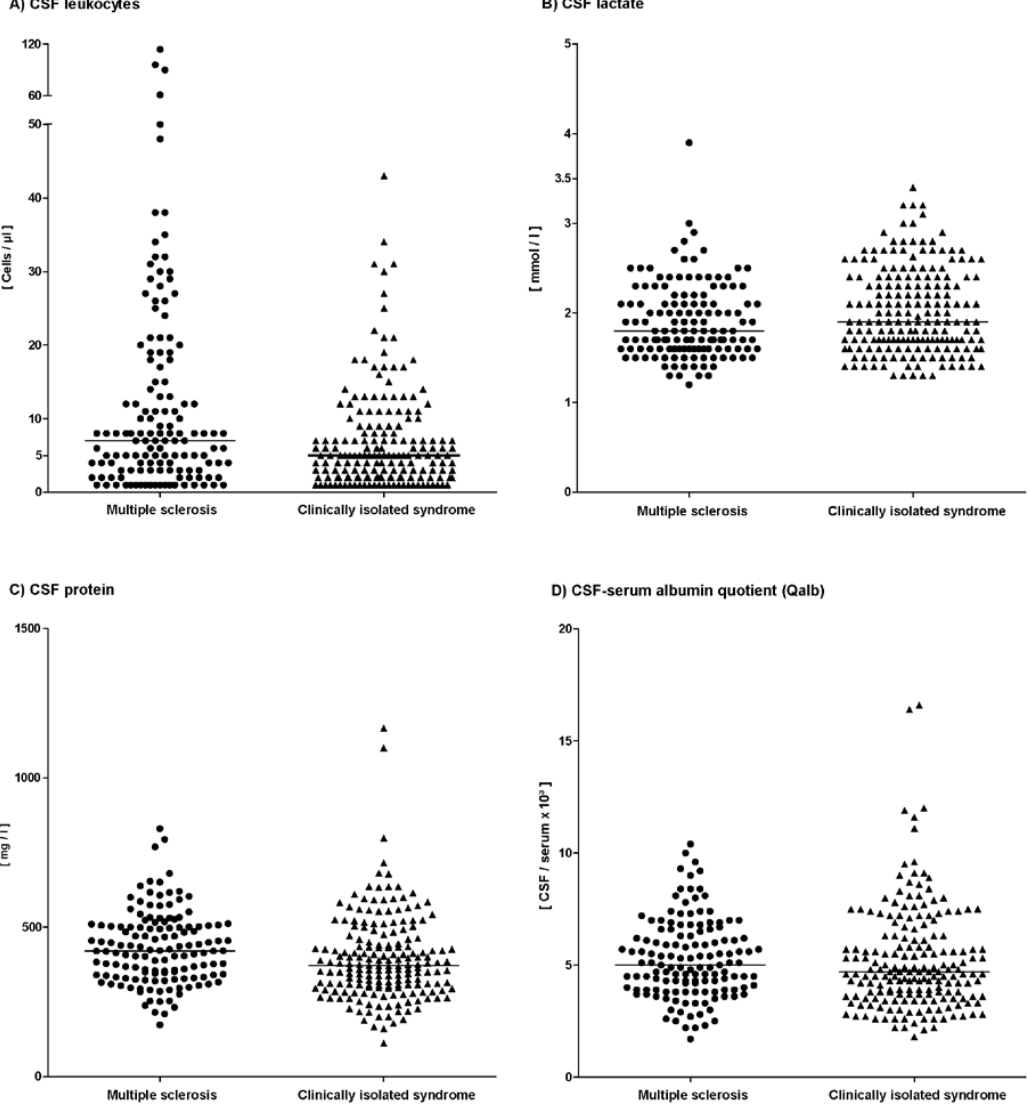
Figure 1. Cerebrospinal fluid results in patients with multiple sclerosis and clinically isolated syndrome according to the McDonald criteria 2010. Graphs show the distribution of cell count ( A ), lactate ( B ), total protein ( C ), and albumin CSF/serum quotients ( D ). Bars represent median values in each group. CSF total protein was elevated in 38 patients (median 421 mg/L, range 173–830 mg/L). Measurements of QAlb, which is the best indicator for a blood-CSF barrier dysfunction, revealed age-corrected increased values in 36 patients (median 5.0, range 1.7–10.4). Barrier impairment was only mild in all of these patients (QAlb <